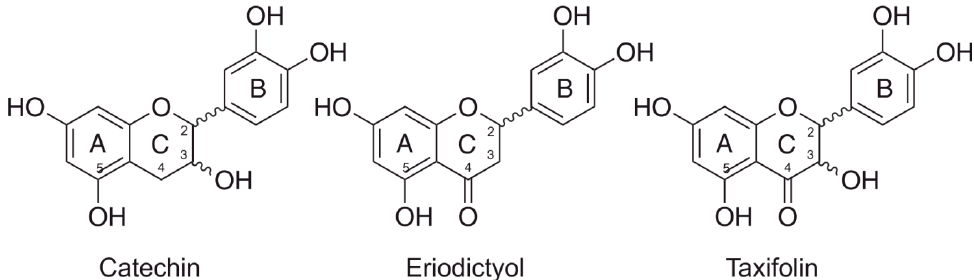
Figure 1. Structures of the flavan-type flavonoids that were included in the study.